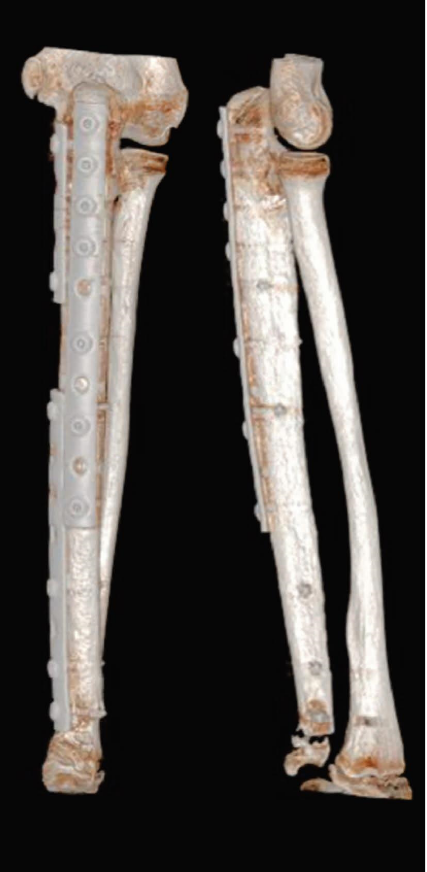
Figure 6: TesamepatientmentionedinFigure 1.CTscanperformed 20 months after the surgery showing good healing at the proximal host-allograft junction and preservation of the distal ulnar